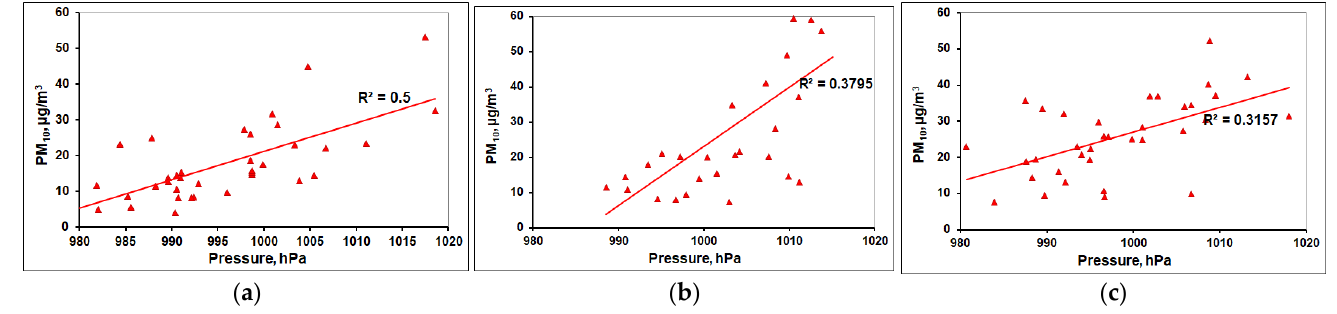
Figure 5. The dependence of the PM 10 aerosol concentration on the air pressure in the surface atmosphere in Moscow during periods of intensive observations through the days outside the episodes of maximum air pollution (Table 2): ( a ) spring 2020; ( b ) autumn 2020; ( c ) spring 2021. R 2 -the reliability coefficient of the linear relationship (straight lines) between variables.